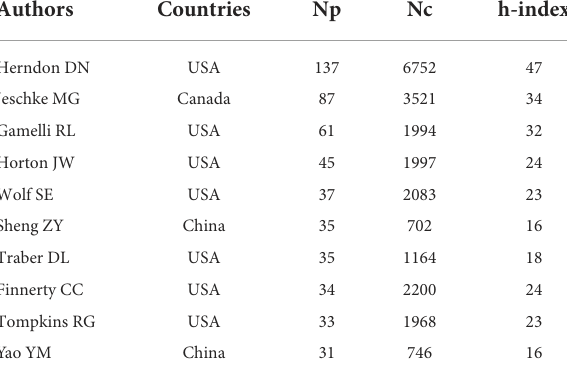
TABLE 1 Top 10 active